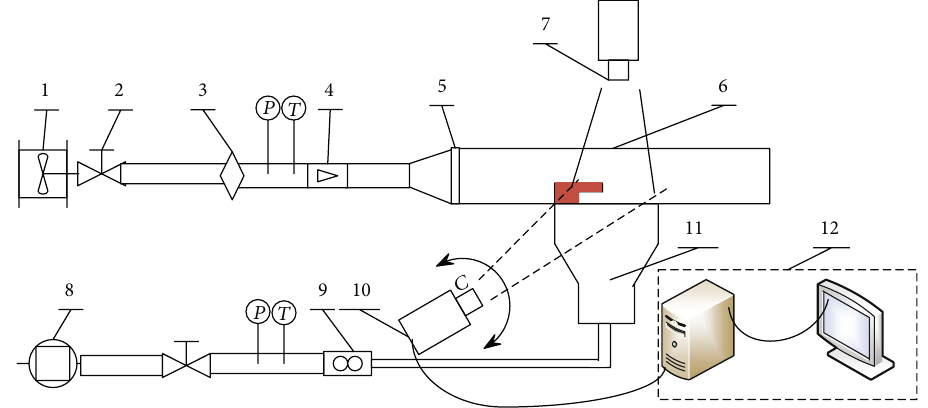
Figure 3: Schematic diagram of the impinging- fi lm cooling experimental system. 1-Single screw compressor; 2-Valve; 3-Electric heater; 4-Vortex fl owmeter; 5-Metal grille; 6-Heat air fl ow chamber; 7-Laser; 8-Piston compressor; 9-Glass rotor fl owmeter; 10-CCD camera; 11-Coolant air fl ow chamber; 12-PIV data processing system.